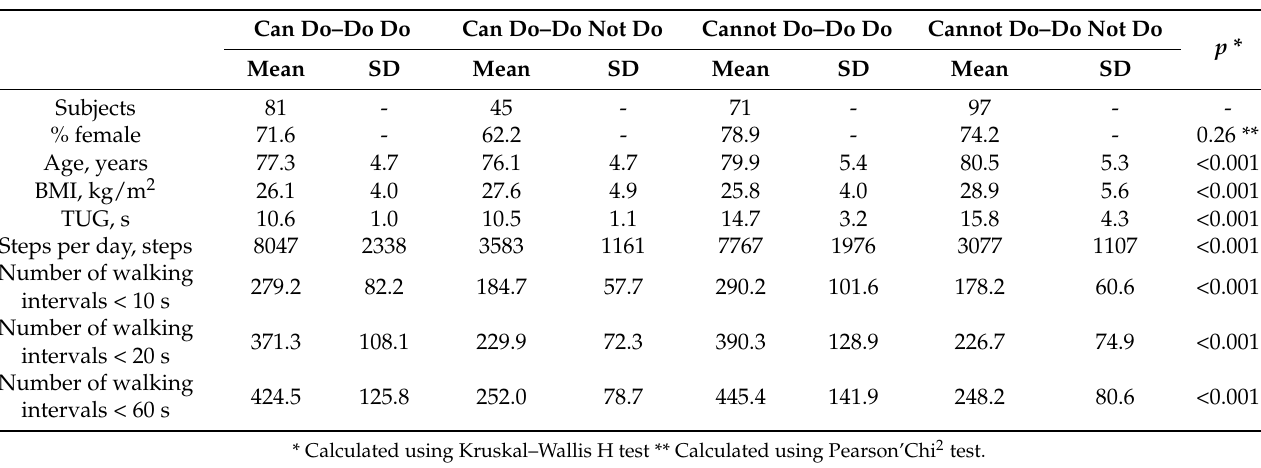
Table 2. Descriptive characteristics of the four quadrants.